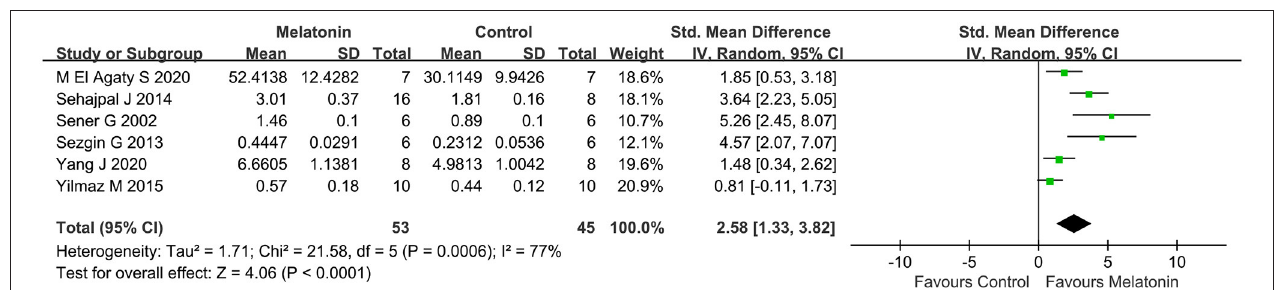
Frontiers in Physiology |